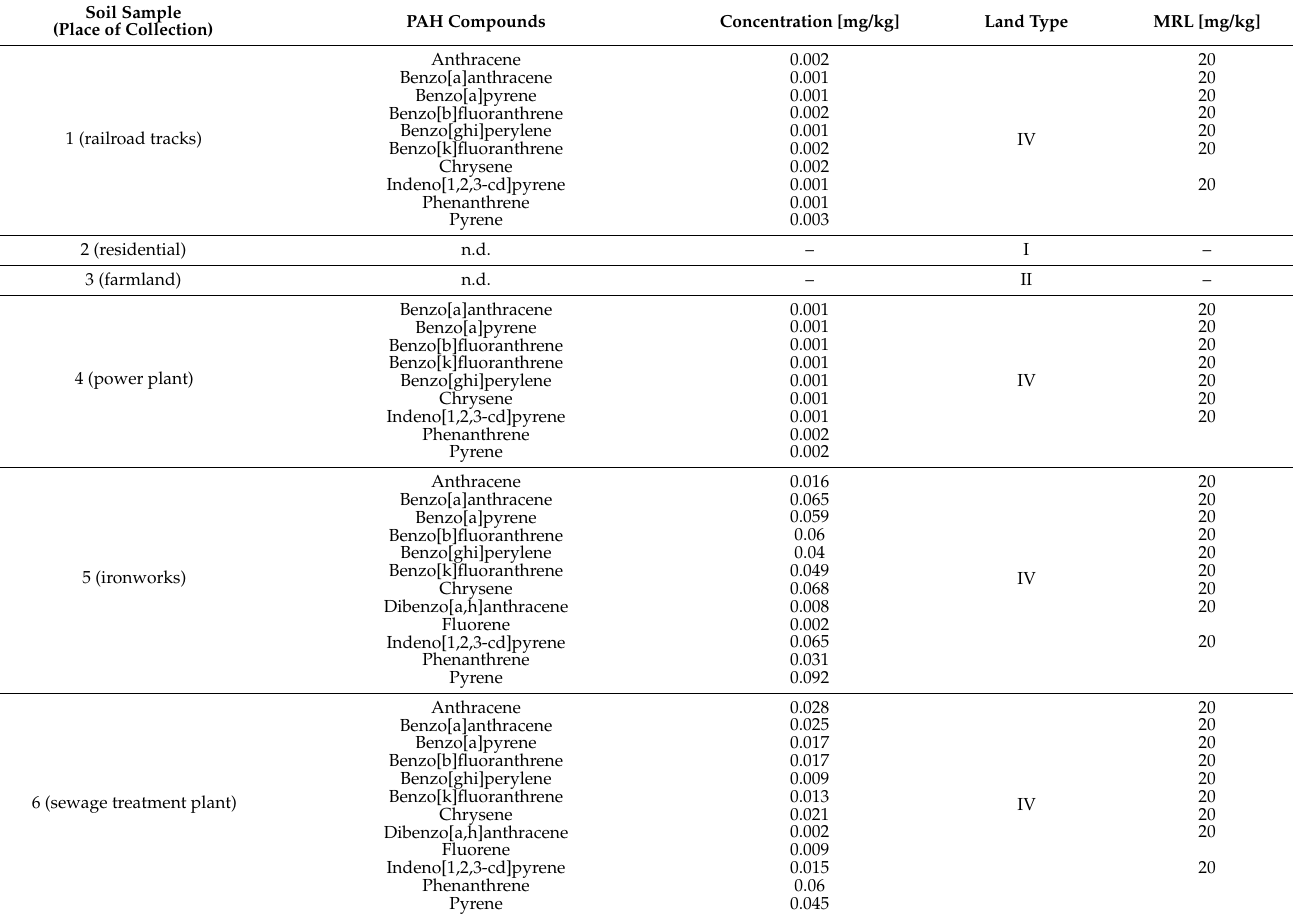
Table 6. PAHs analysis in real soil